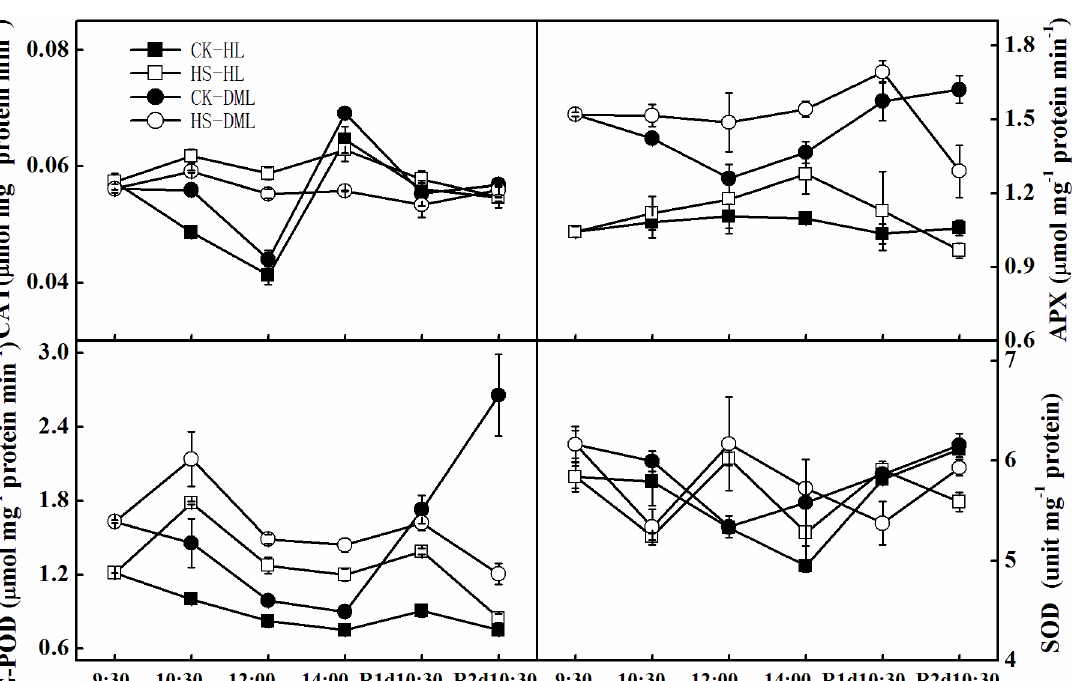
Fig 5. Effects of heat shock and recovery on catalase (CAT), ascorbate peroxidase (APX), superoxide dismutase (SOD) and guaiacol peroxidase (G-POD) activities in leaves of healthy and downy mildew-infected cucumber. The data represent the mean ± SE (n = 5).